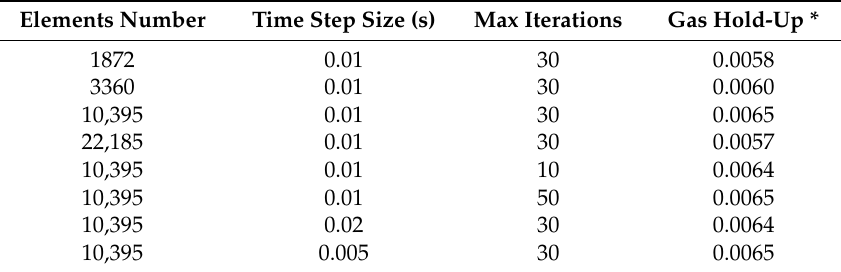
Table 2. Gas hold-up values with different